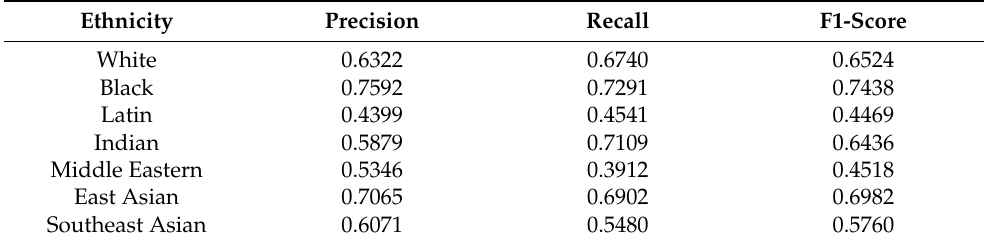
Table 17. Results for the FairFace filtered testing with plotted landmarks.